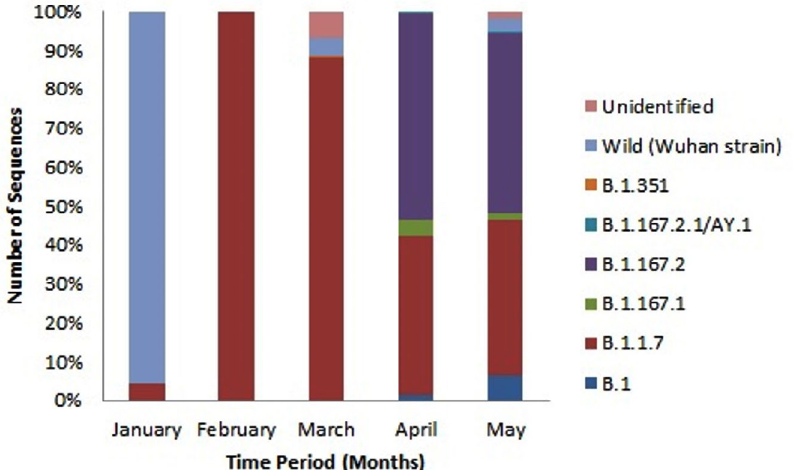
Fig. 3. Distribution of SARS-CoV-2 variants during the time period of January 2021 to May 2021. At the start of second wave till January wild type variant was dominating but by the end of May other variants of SARS-CoV-2 has emerged and circulated among the